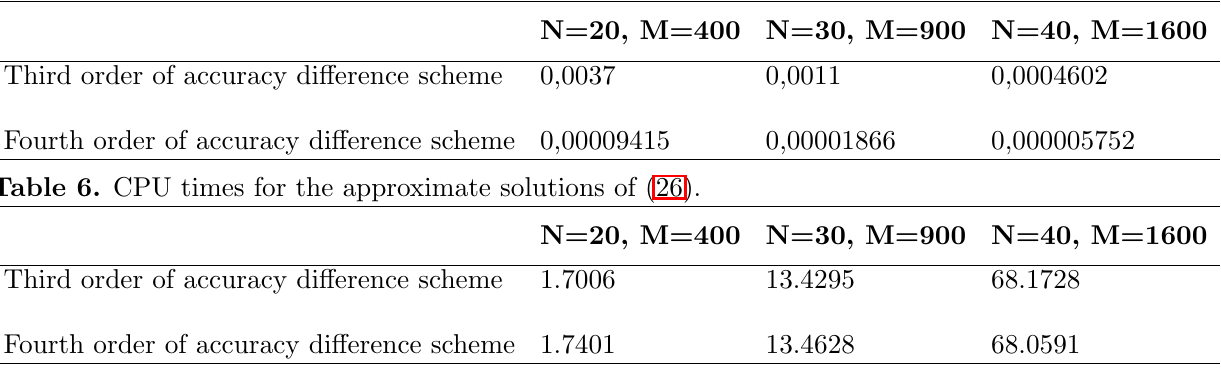
Table 5. Error analysis for the approximate solutions of (26).